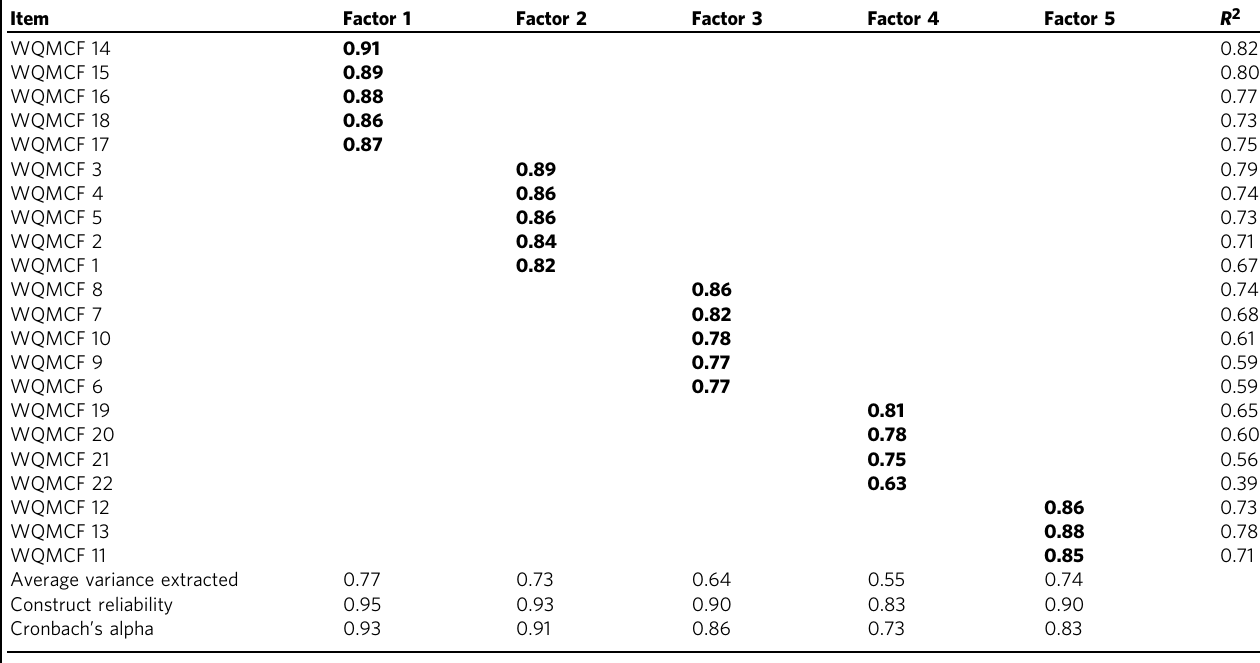
Table 6 Standardized factor loadings, R 2 , variance extracted and reliability estimates for the hypothesized fi ve-factor model (22 items).